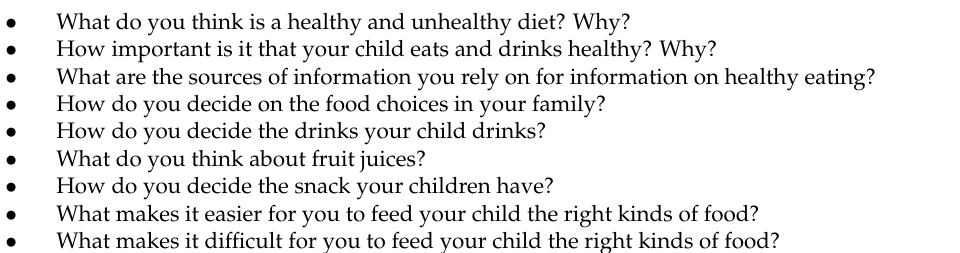
Table 1. Semi-structured interview